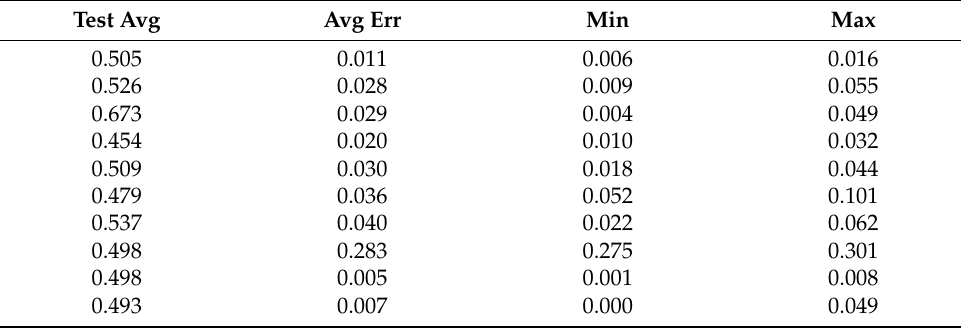
Table A83. Set 2, trials 1–10 data (single 0.5 PR